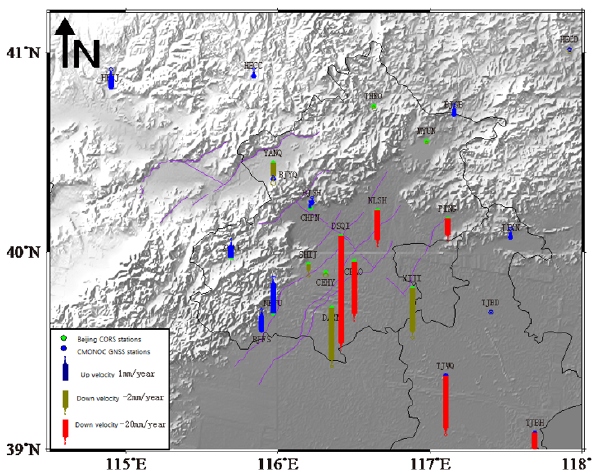
Figure 5. The Vertical crustal deformation velocity resulted from GPS observation. Figure 7. The mean velocity field of crustal deformation along the line of sight (LOS) direction from 2012-2015 derived from RADARSAT-2 WIDE mode SAR images.